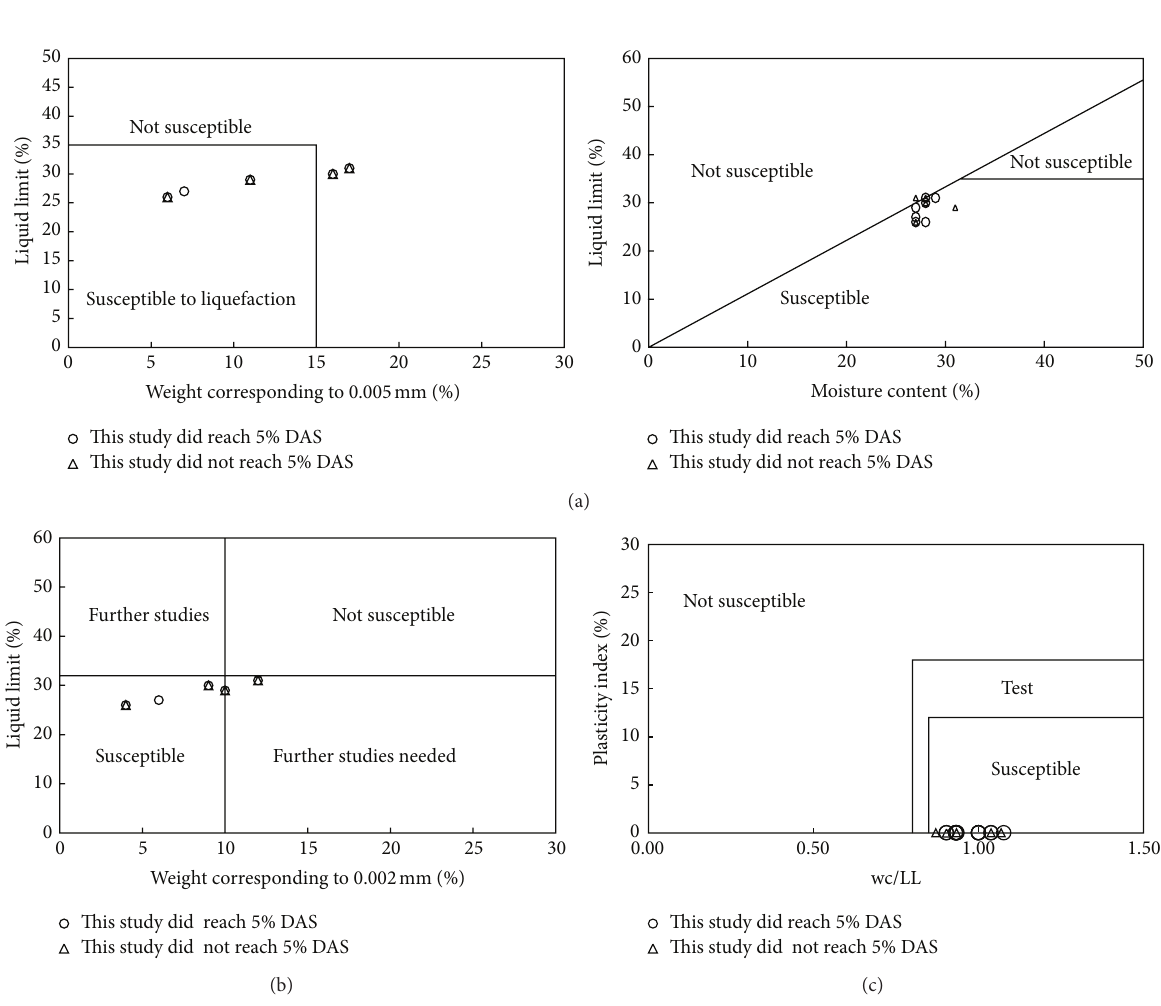
Figure 7: Graphical presentation of criteria. (a) The Chinese criteria [51]. (b) Andrews and Martin’s criteria [52]. (c) Bray and Sancio’s criteria